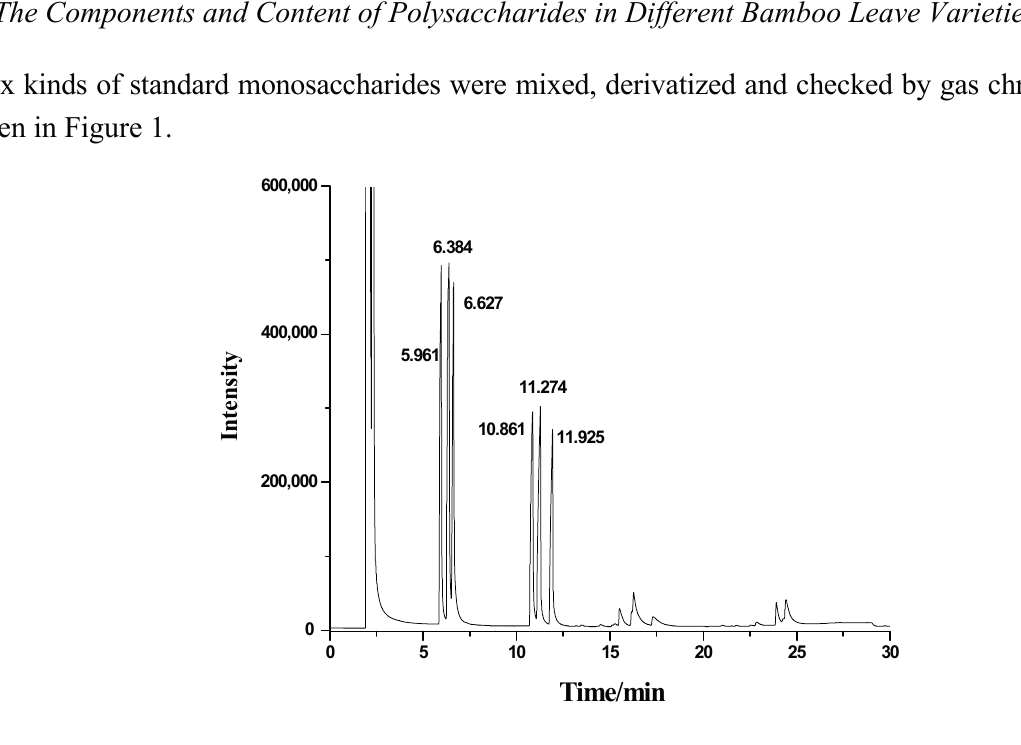
Figure 1. GC trace of standard